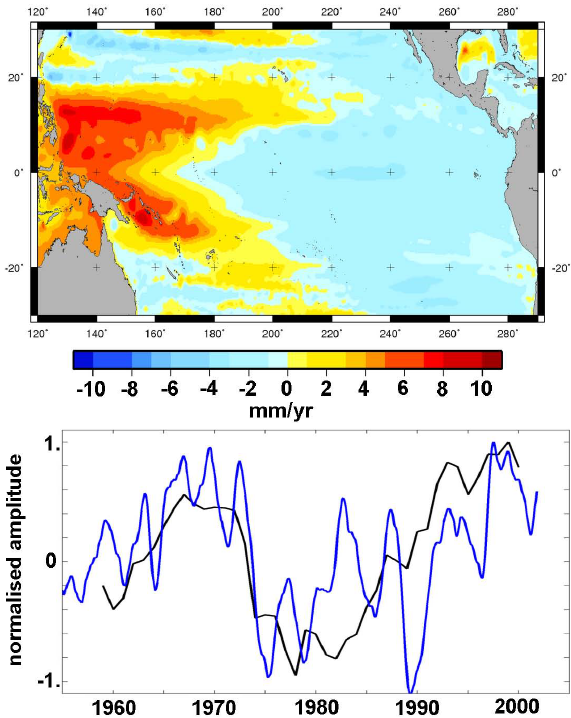
Fig. 3. First rotated EOF of the set of 17-yr trend maps computed with the reconstruction over the tropical Pacific. It explains 37% of the total variance. The PC is the black curve. The NINO3 index from Kaplan et al. (1998), filtered with a 10-yr running mean and detrended, is superimposed in blue. Their correlation coefficient is 0.63 (SL >